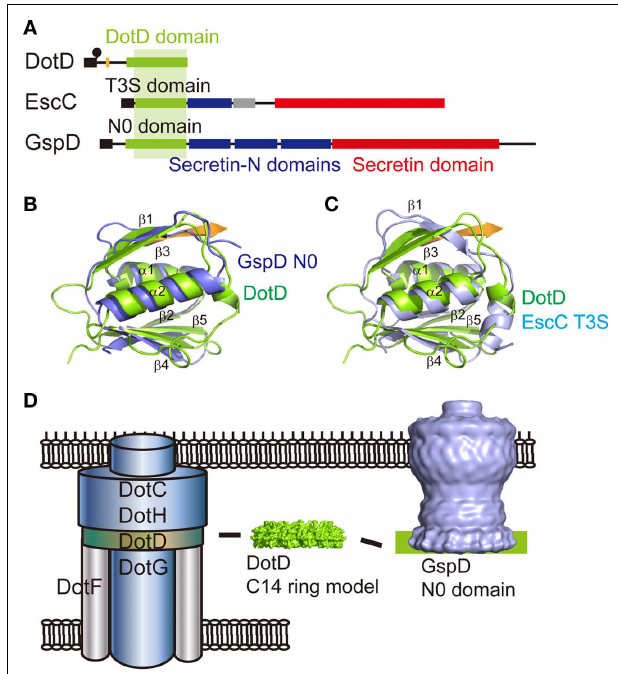
FIGURE 5 | Comparison of the C-terminal domain of DotD with secretin periplasmic subdomains. (A) Domain organizations of L. pneumophila DotD (Nakano et al., 2010), EPEC secretin EscC (Spreter et al., 2009), and ETEC secretin GspD (Korotkov et al., 2009). (B) DotD (green, PDB accession 3ADY) superimposed onto the N0 domain of ETEC secretin GspD (blue, PDB 3EZJ). (C) DotD (green) superimposed onto the T3S domain of EPEC secretin EscC (light blue, PDB 3GR5). (D) A model of T4BSS core complex. DotD may form a periplasmic ring, like the N0 domain of type II